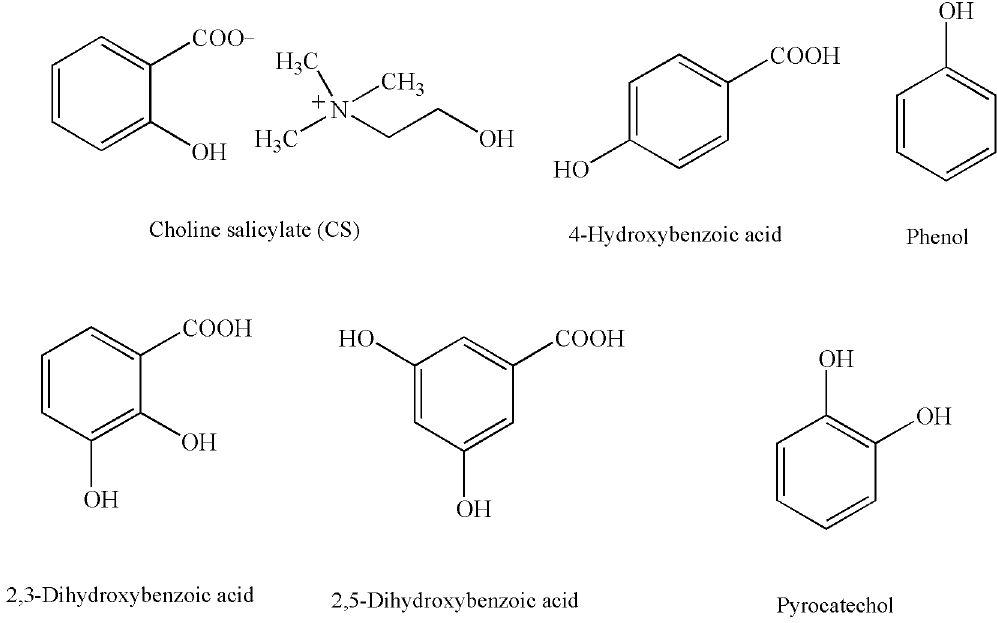
Figure 1. Structural formulas of choline salicylate (CS) and its possible impurities and degradation products.